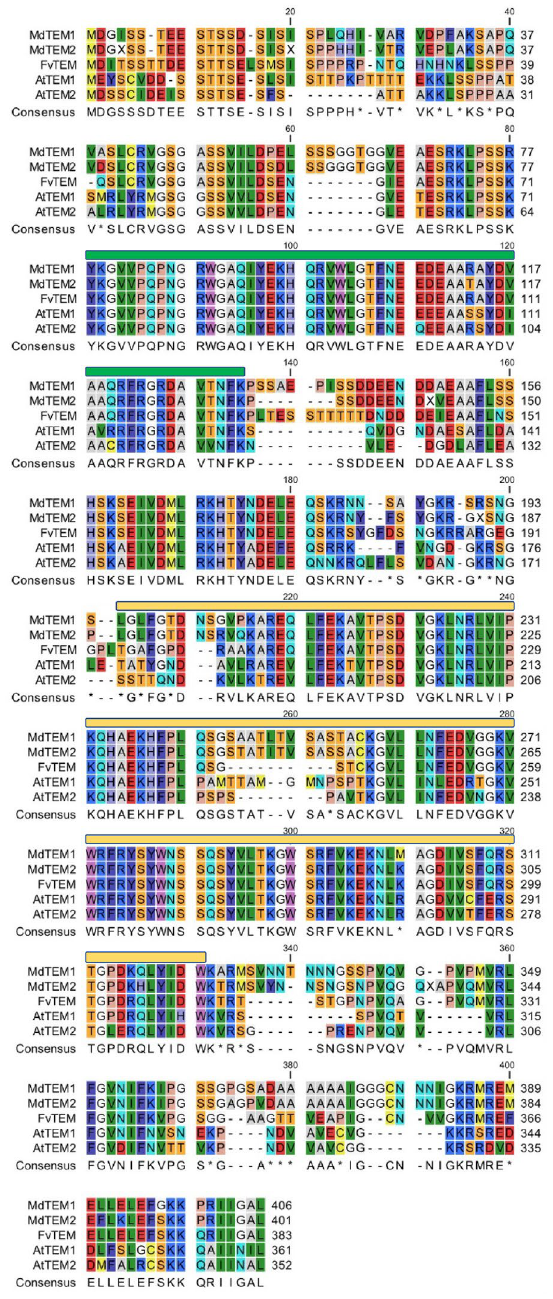
Figure 2. Amino acid sequence alignment of TEM proteins from apple, strawberry and Arabidopsis using CLUSTAL W method. The MdTEM1 (ON045007-translated), MdTEM2 (ON045008-translated), FvTEM (ON107496-translated), AtTEM1 (NP_173927.1) and AtTEM2 (NP_564947.1) sequences were used. The AP2 and B3 conserved domains were visualized by green and yellow bars, respectively. Alignment was carried out by MEGA11 and illustrated by CLC Genomics Workbench Version 21.0.5